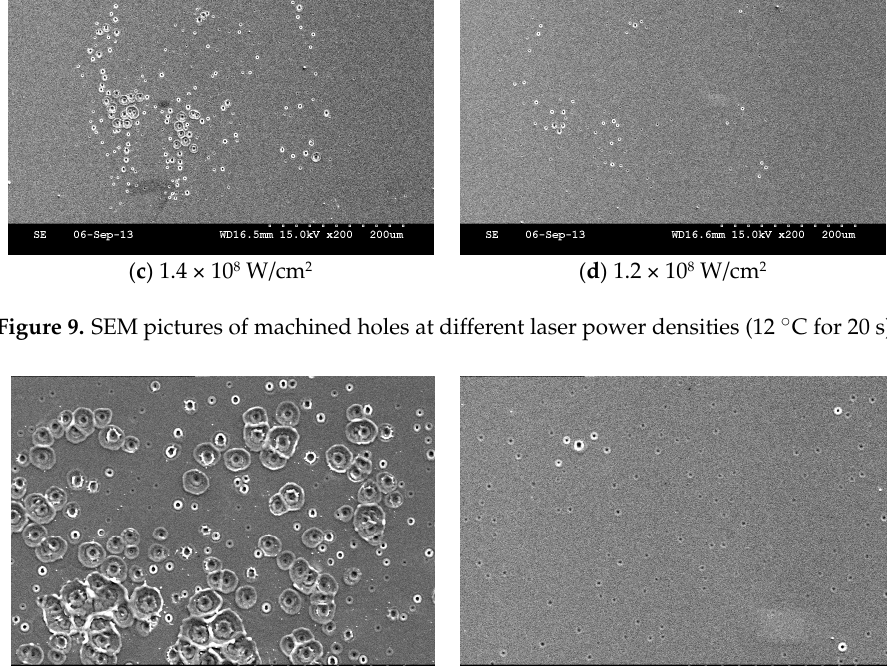
Figure 9. SEM pictures of machined holes at different laser power densities (12 ∘ C for 20 s).